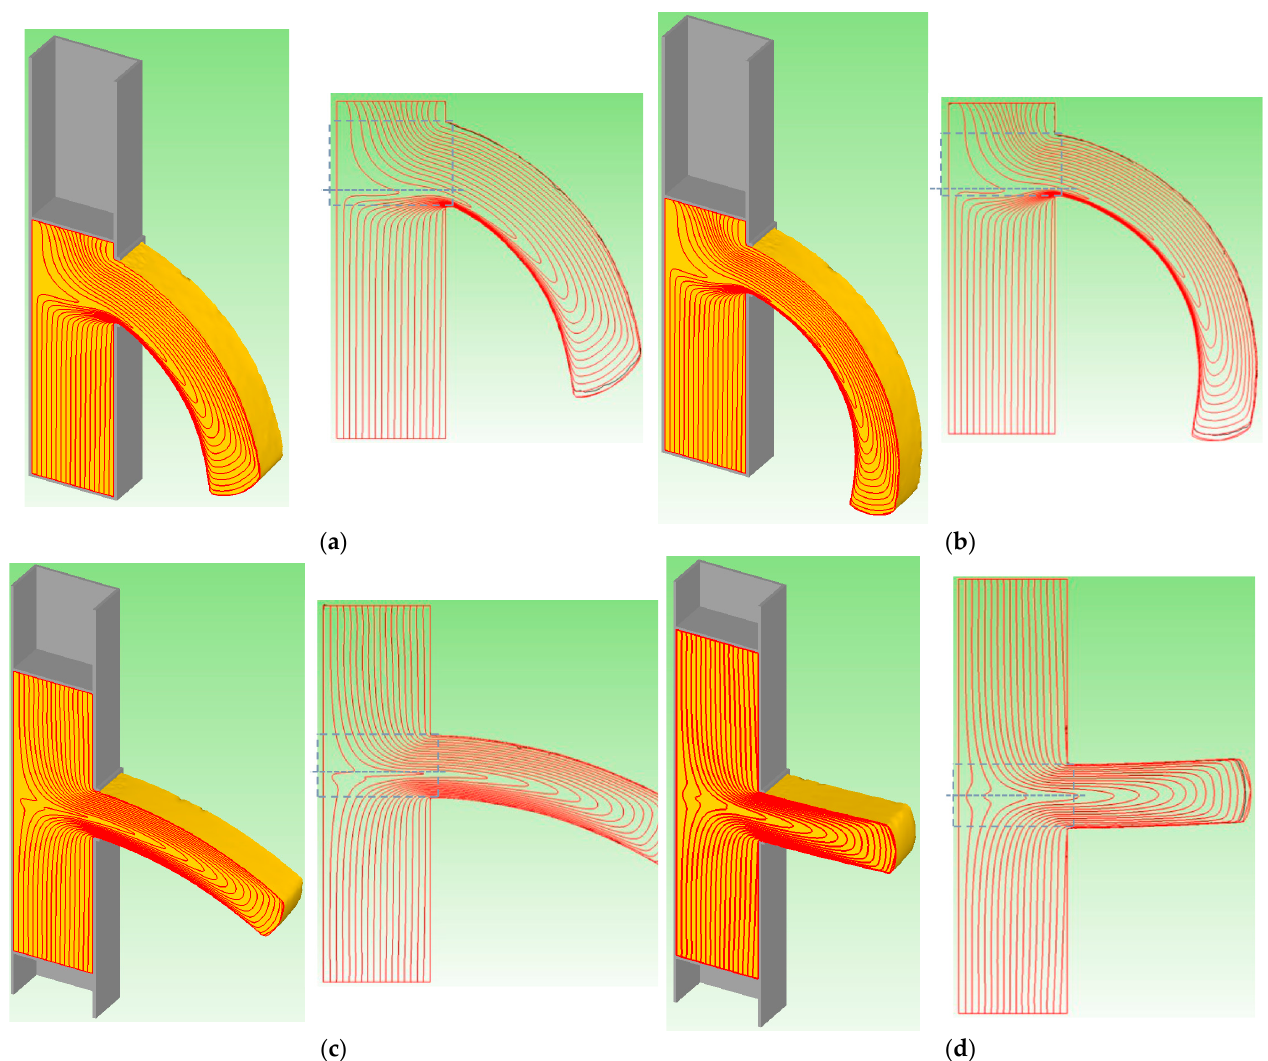
Figure 3. Material flow lines at different extrusion ratios and velocity ratios: ( a ) λ = 1.28, v 2 / v 1 = 0, ( b ) λ = 1.71, v 2 / v 1 = 0, ( c ) λ = 1.71, v 2 / v 1 = 0.5 and ( d ) λ = 1.71, v 2 / v 1 = 1.